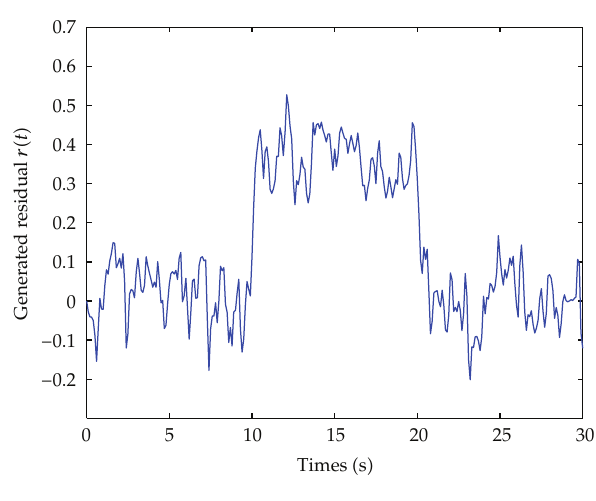
Figure 4: Generated residual signal r (cid:6) t (cid:7) .